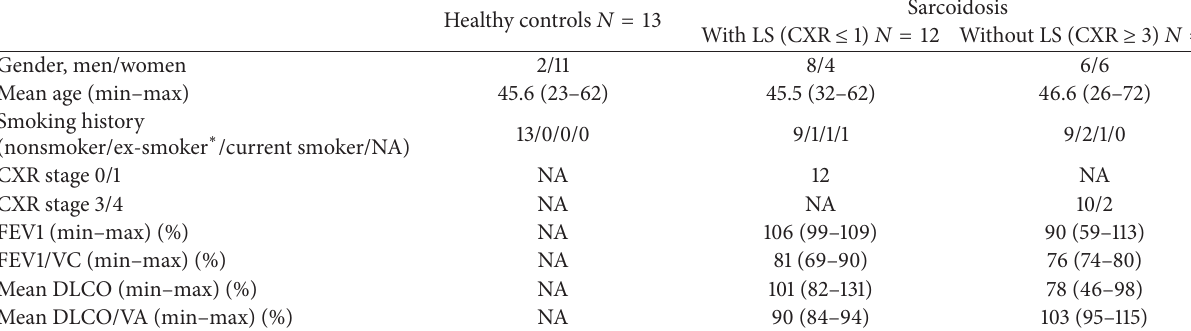
Table 1: Clinical characteristics of our patients with pulmonary sarcoidosis and healthy controls.